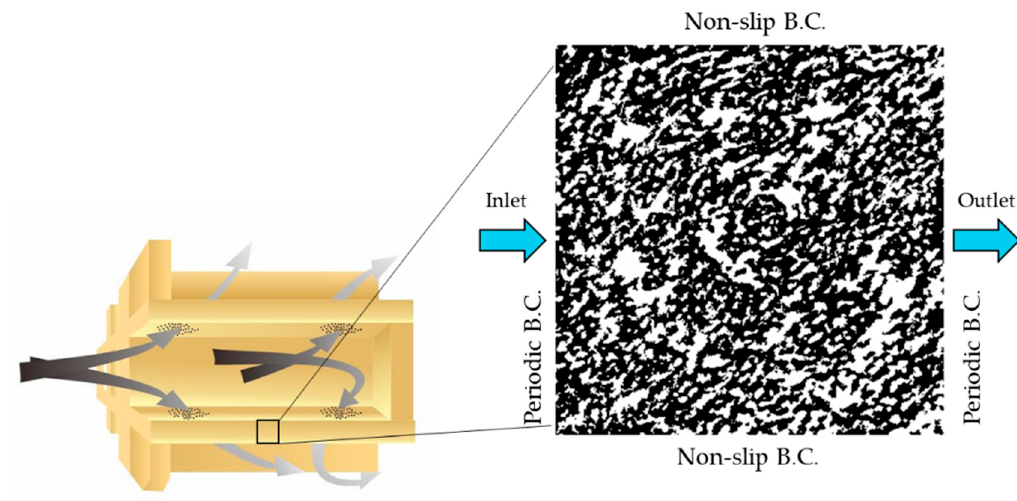
Figure 14. The structure of the inner wall of the particulate filters by tomography and the schematic diagram of calculating area.